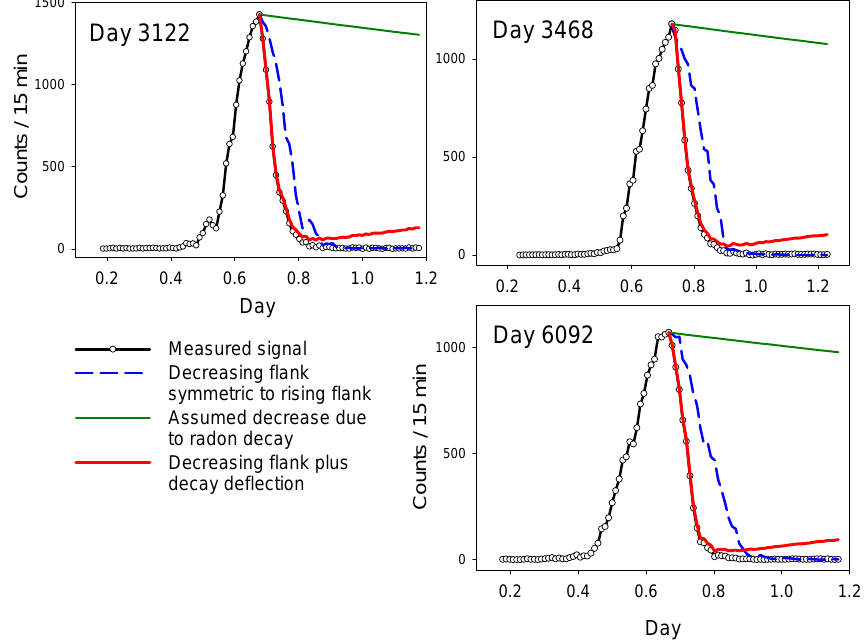
Figure 10: E xamples of intense asymmetric sub-diurnal radon (SDR) signals, having a steeper declining limb. Accounting for the radioactive decay of radon from peak time does not correct the asymmetry (see text).